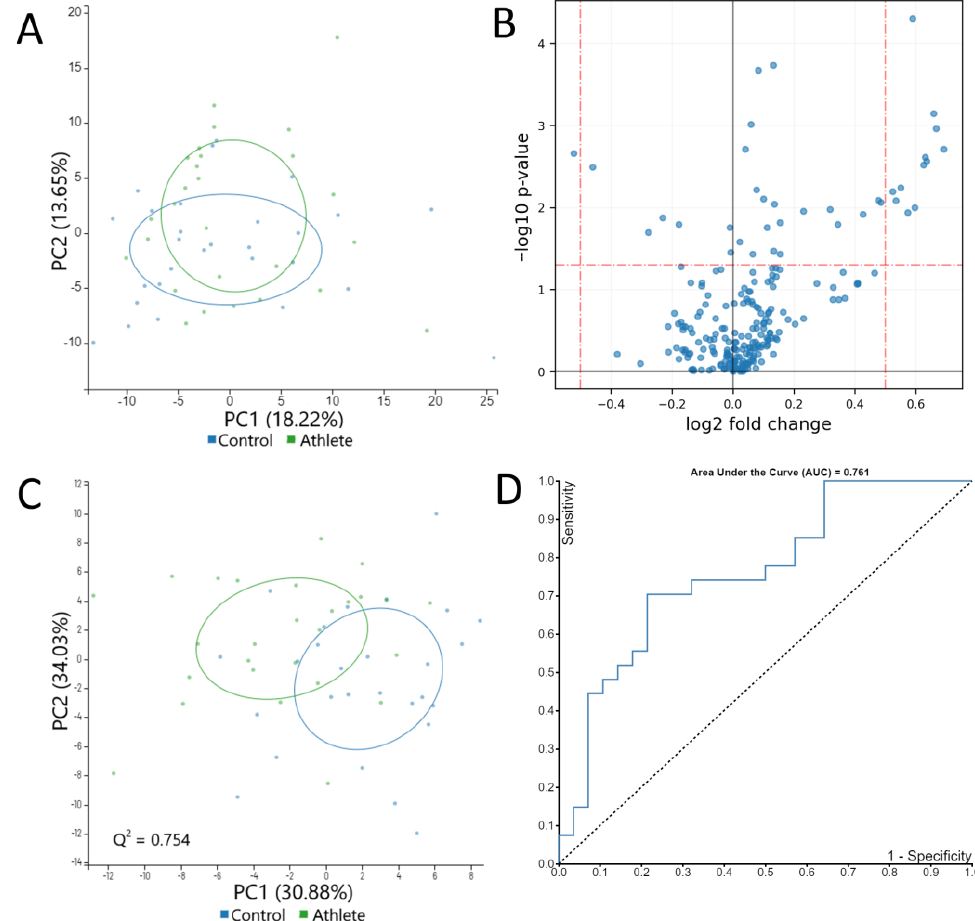
Figure 4. ( A ) The principal component (PC) analysis plot of all metabolites shows that most of the variance was explained by other factors than group. ( B ) The volcano plot indicates that the group differences were less than 2-fold for all metabolites. ( C ) The partial least squares-discriminant analysis plot and ( D ) receiver operand characteristics curve for random forest show that the classification task reached moderate accuracy.